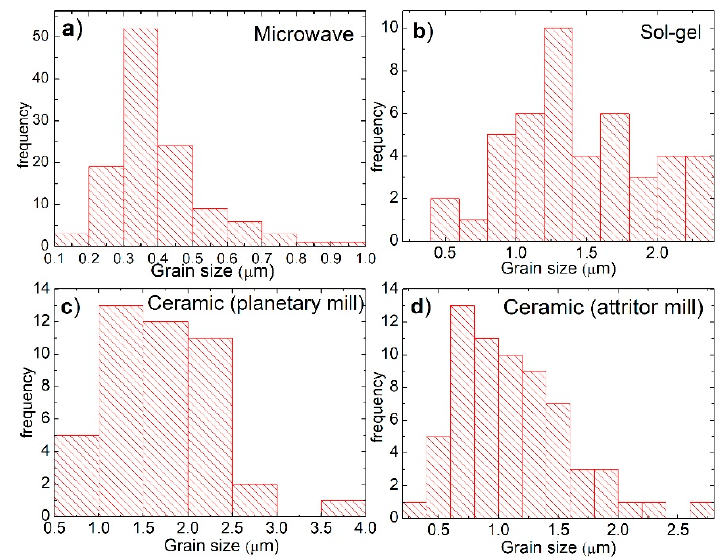
Figure 3. Particle average size histograms from the observed SEM images of manganites manufactured by: ( a ) microwave-assisted sol-gel; ( b ) Pechini sol-gel; ( c ) solid-state reaction with planetary mill; and ( d ) solid-state reaction with attrition mill.